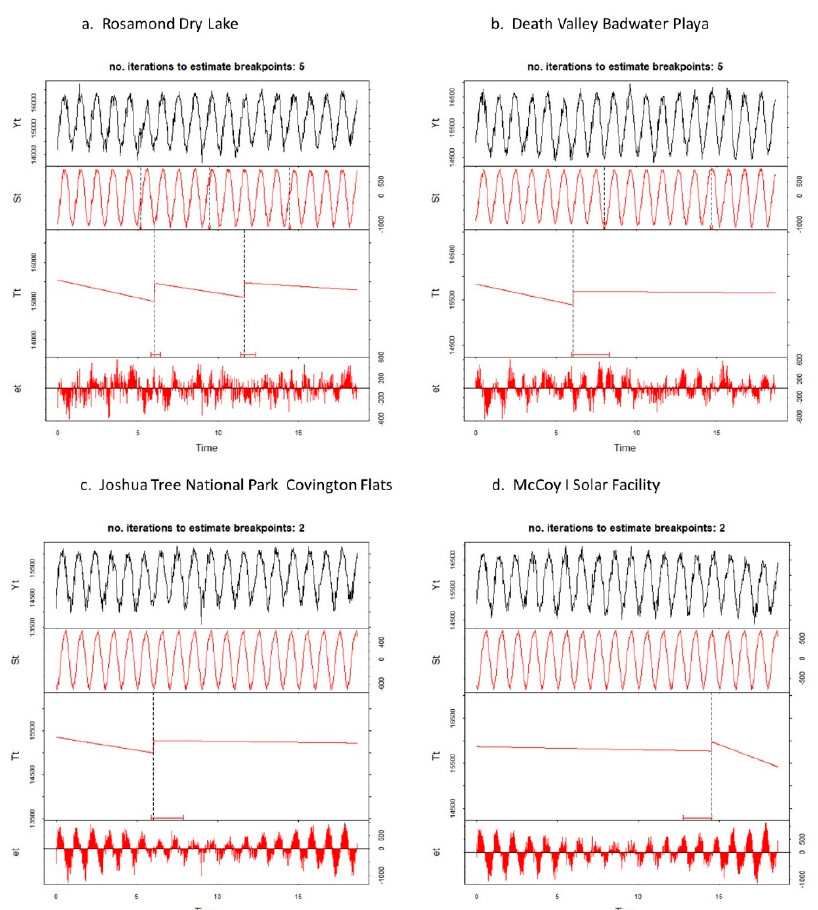
Figure 2. Breaks for Additive Seasonal and Trend (BFAST) output plots for four locations between 2000 and 2018 for the Moderate-Resolution Imaging Spectroradiometer (MODIS) land surface temperature (LST) 1-km monthly time series. Y(t) is the time-series of MODIS LST values; S(t) is the fitted seasonal component; T(t) is the fitted trend component; e(t) is the noise component; statistical breakpoints ( p < 0.01) are identified by vertical dashed lines. Year numbers on the horizontal axis start at 1 = 2000 and end in early 2018. ( a , b ) show two dry lakes, ( c ) shows a burned area in the National Park, and ( d ) shows a newly constructed solar energy facility.